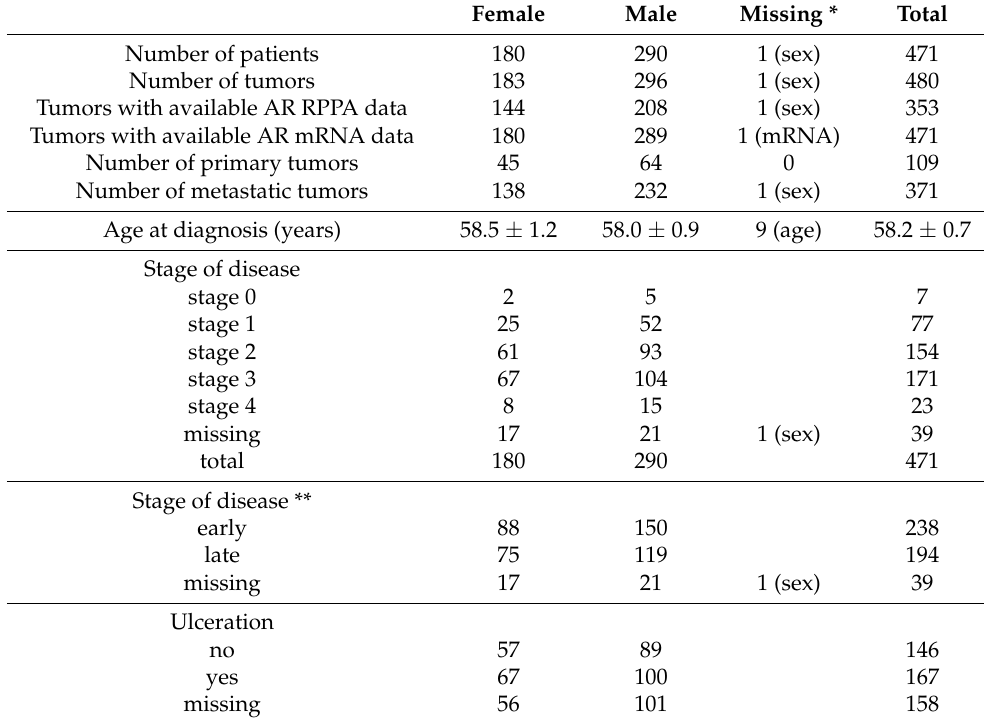
Table 1. Baseline characterization of